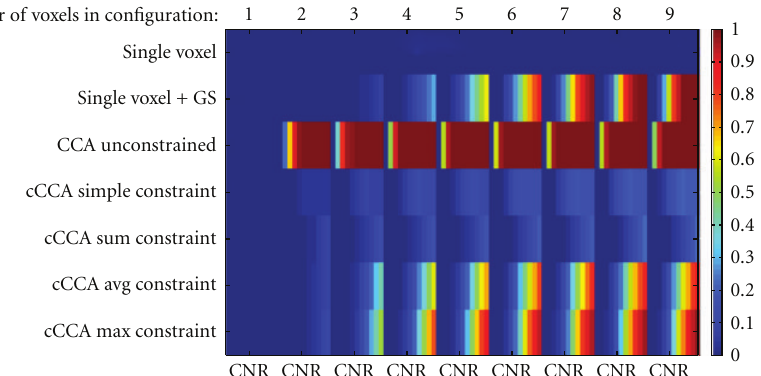
Figure 1: Smoothing artifact of the center voxel for di ff erent analysis methods as a function of the configuration size and CNR for simulated motor activation data. Note that the figure is composed of 9 separate images belonging to configuration sizes 1 to 9, and each image for a particular configuration size is a function of the CNR ranging from 0 to 1 in steps of 0.1 in the horizontal direction. The center voxel for each configuration is by design nonactive and the other members (neighboring voxels belonging to the particular configuration) are active with given CNR. In general the smoothing artifact increases with increasing CNR except for single-voxel analysis, where no artifact exists (as expected). Regarding the computation of the false positive fraction, the statistical thresholds were chosen corresponding to a family-wise error rate (FWE) < 0.05 for re-sampled restingstate data.